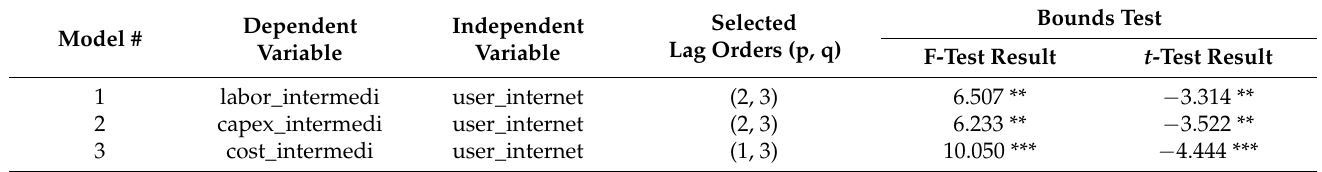
Table 3. Lag orders and result of bounds test for the selected dependent variables.